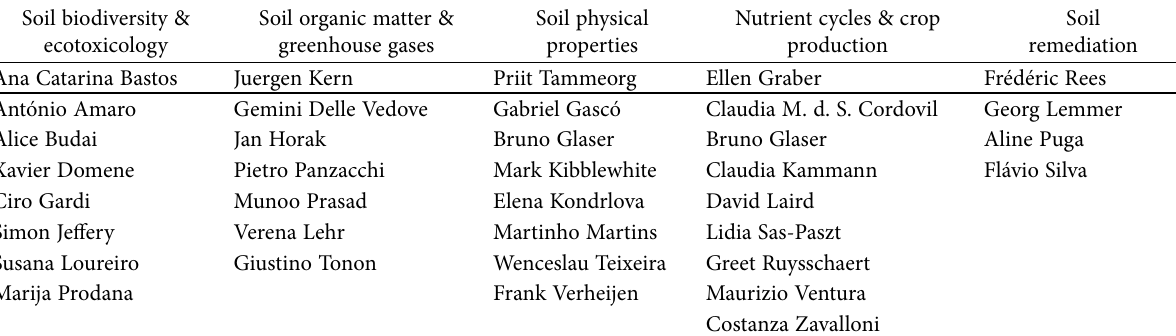
Table 1. Organisation of the five thematic groups (the names of facilitators/discussion leaders of each thematic group underlined), largely based on the structure of working groups 2 (land use implementation) and 4 (environmental impact assessment) of the COST Action TD1107